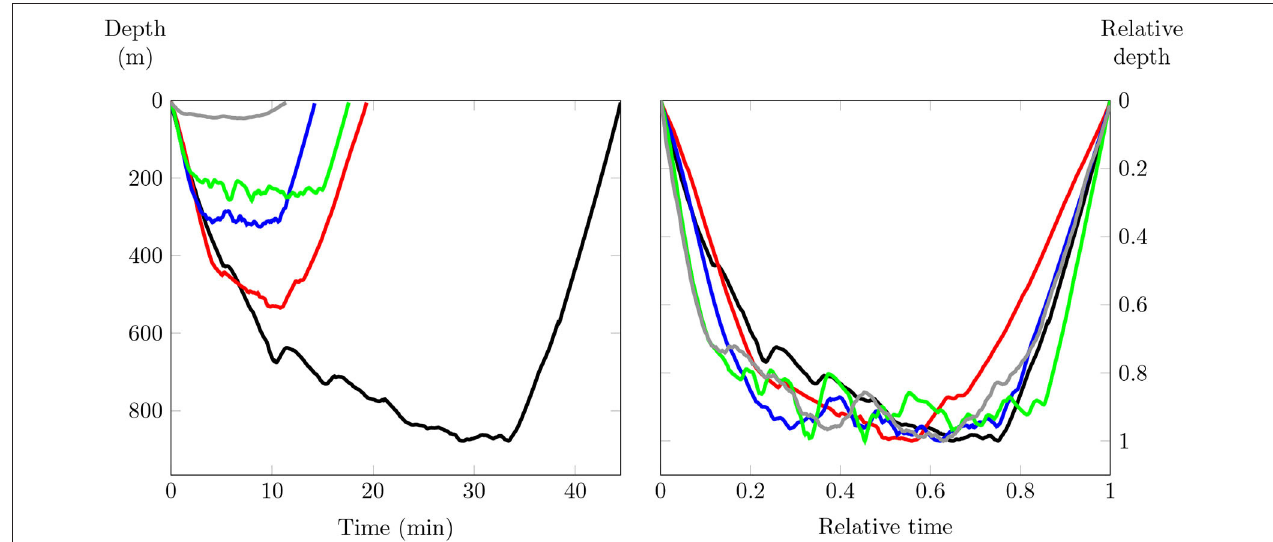
FIGURE 5 | On the left, the representation of some dives (raw data). On the right, the representation of the same dives after normalization. Dives have different maximum depth, different duration, but dive patterns are